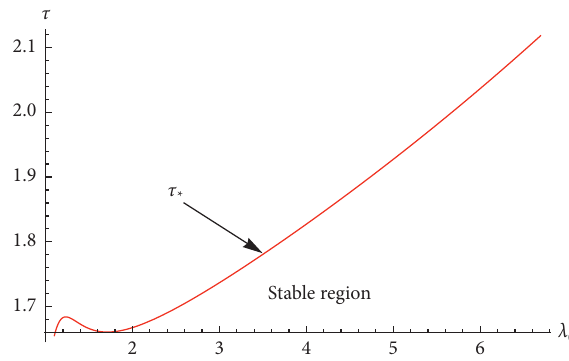
Figure 2: Bifurcation diagram of system (3) with parameter λ